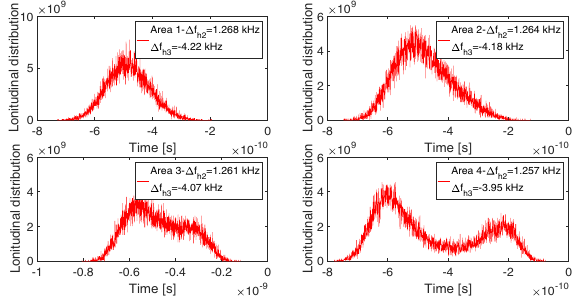
FIG. 10. Final distribution varies with the detuning frequencies of the 2nd and 3rd harmonic cavities, the bunch is nearly optimal lengthened in the upper two figures, while the bunch is over- stretched in the bottom figures.